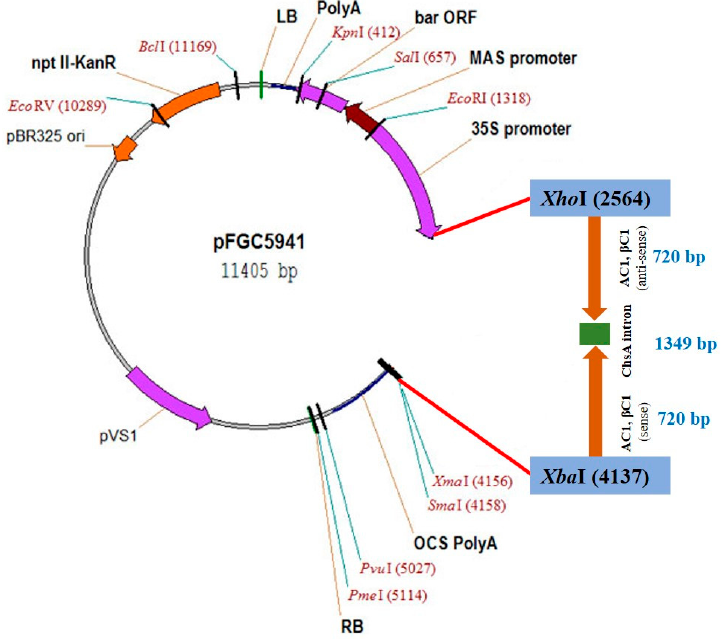
Figure 1. Map of the V β construct.